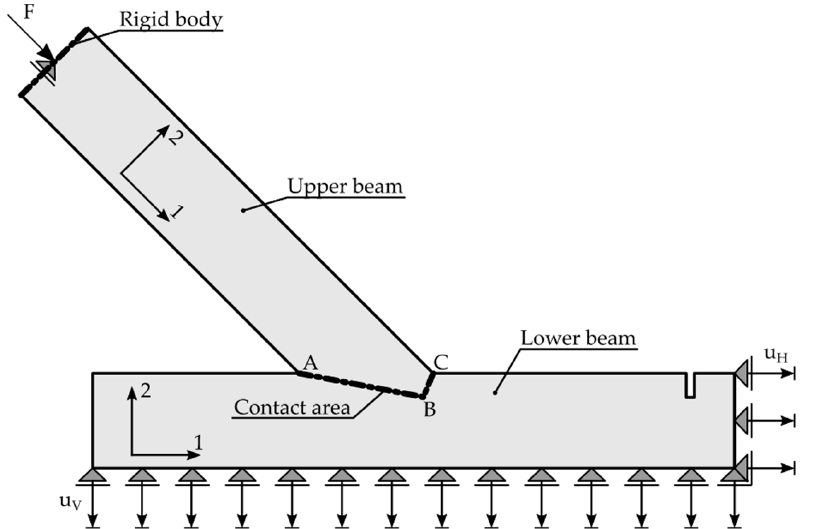
Figure 7. Geometry and designations of the FEM model for the single-step joint. Axis 1 represents the orientation parallel to the grain.